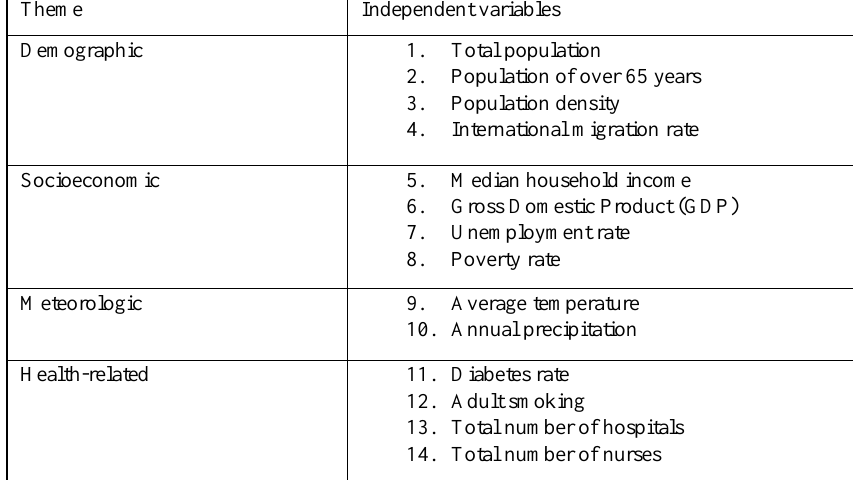
Table 1. Description of explanatory variables used in this study.